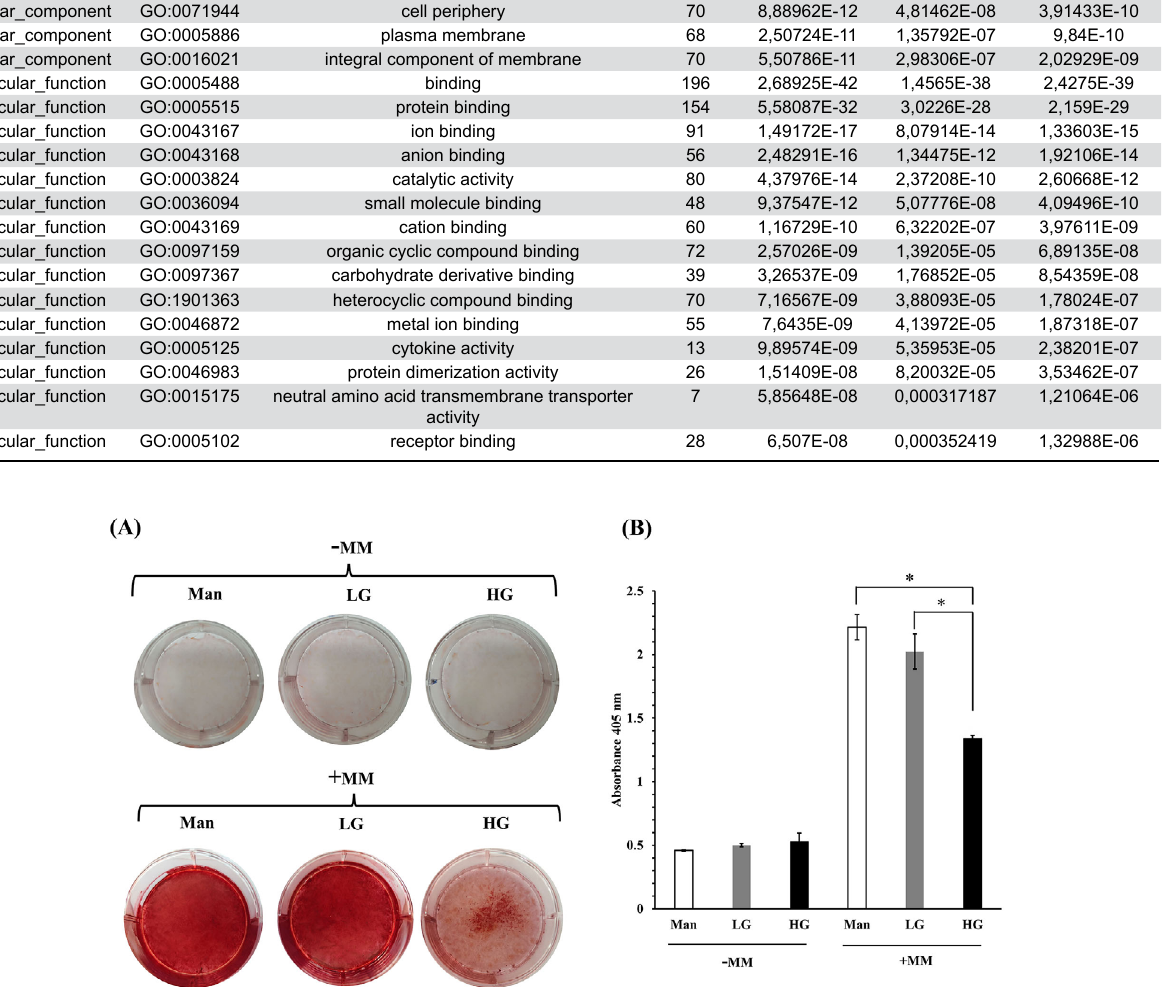
Figure S2- Mineralization of hDPCs. Staining of the alizarin red S–calcium complex; (A) Overview, (B) quantitation of mineral deposition. Mineralizing medium (MM), Low glucose (LG), 25 mM Mannitol (Man), and High glucose (HG). * indicates a statistically significant difference between groups (p<